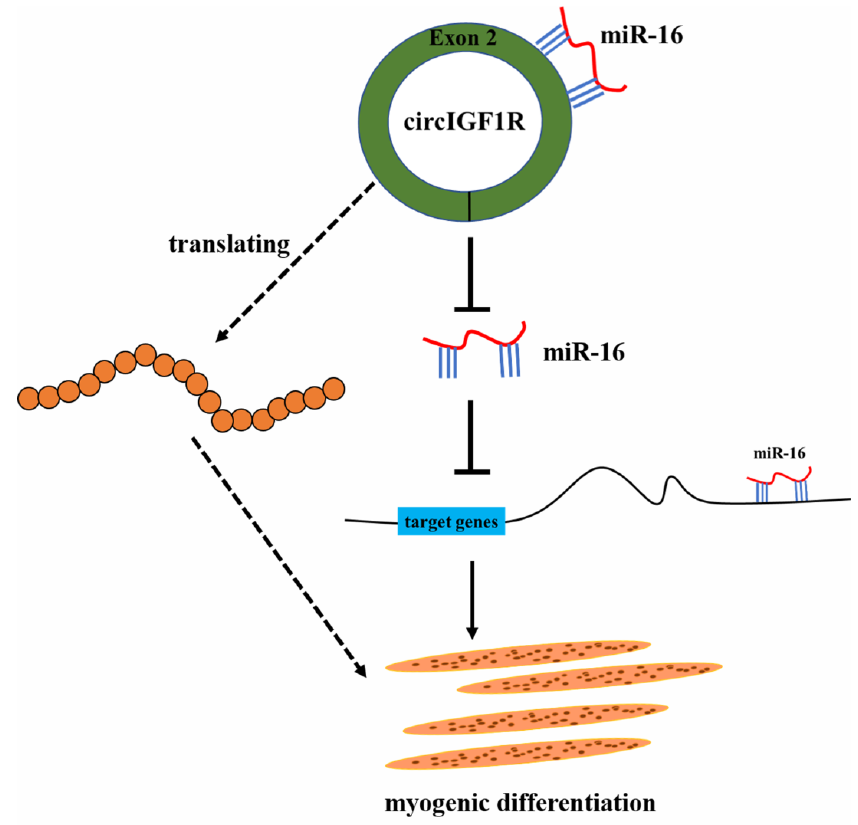
Figure 9. Mechanism of circIGF1R regulating myoblast differentiation through miR-16.